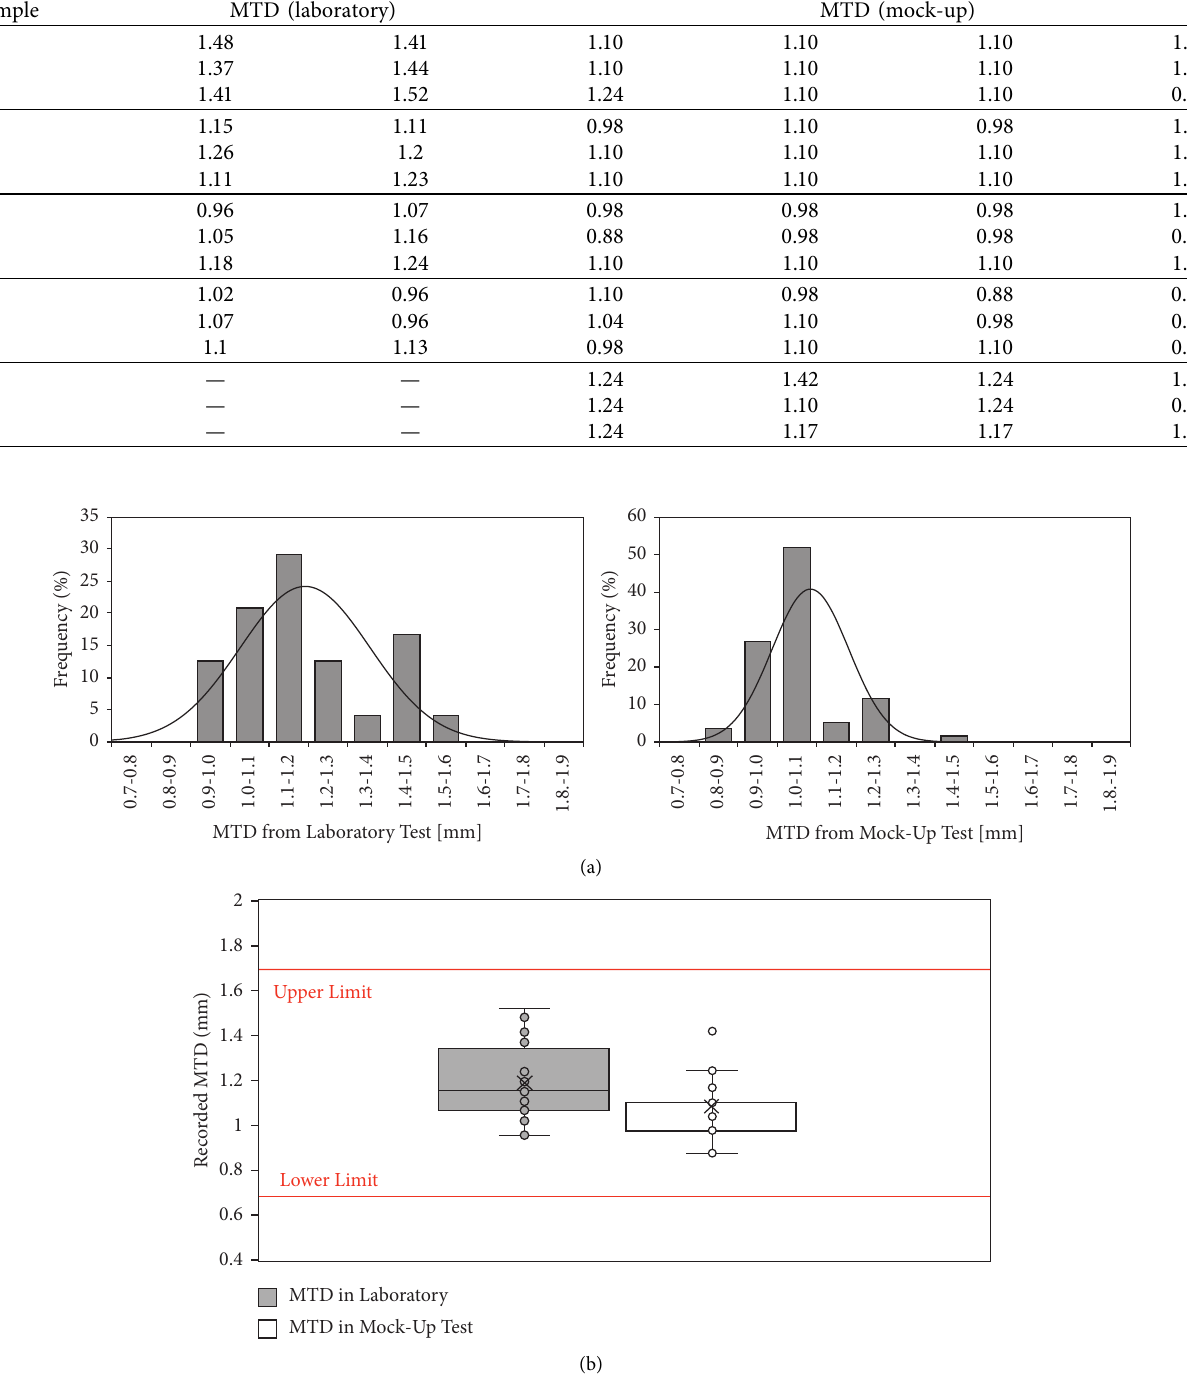
Figure 10: Comparison of mean texture depth from the laboratory and mock-up test: (a) collected mean texture depth from the laboratory and mock-up test; (b) statistical comparison of mean texture depth from the laboratory and mock-up test.